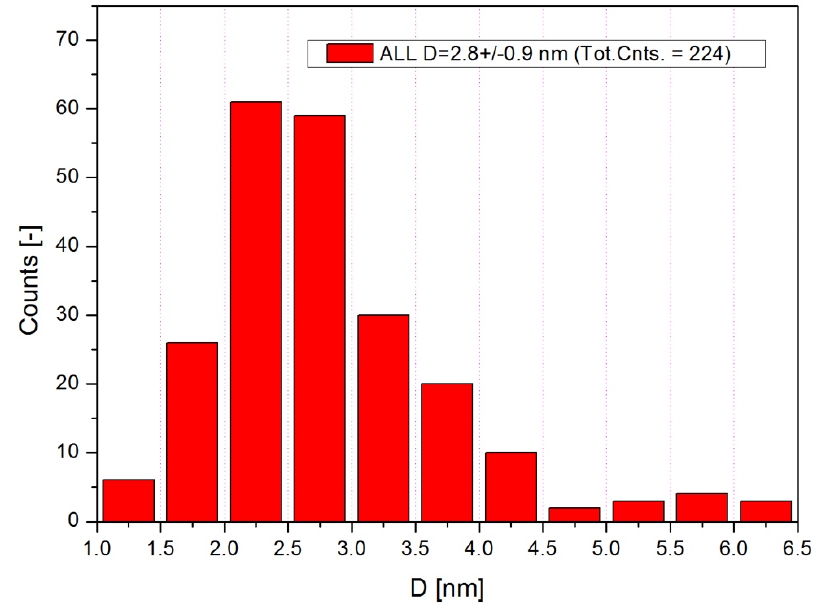
Figure 10. The counts distribution of particles size, from all four samples. Table 1. The size distribution particles as a function of counts.